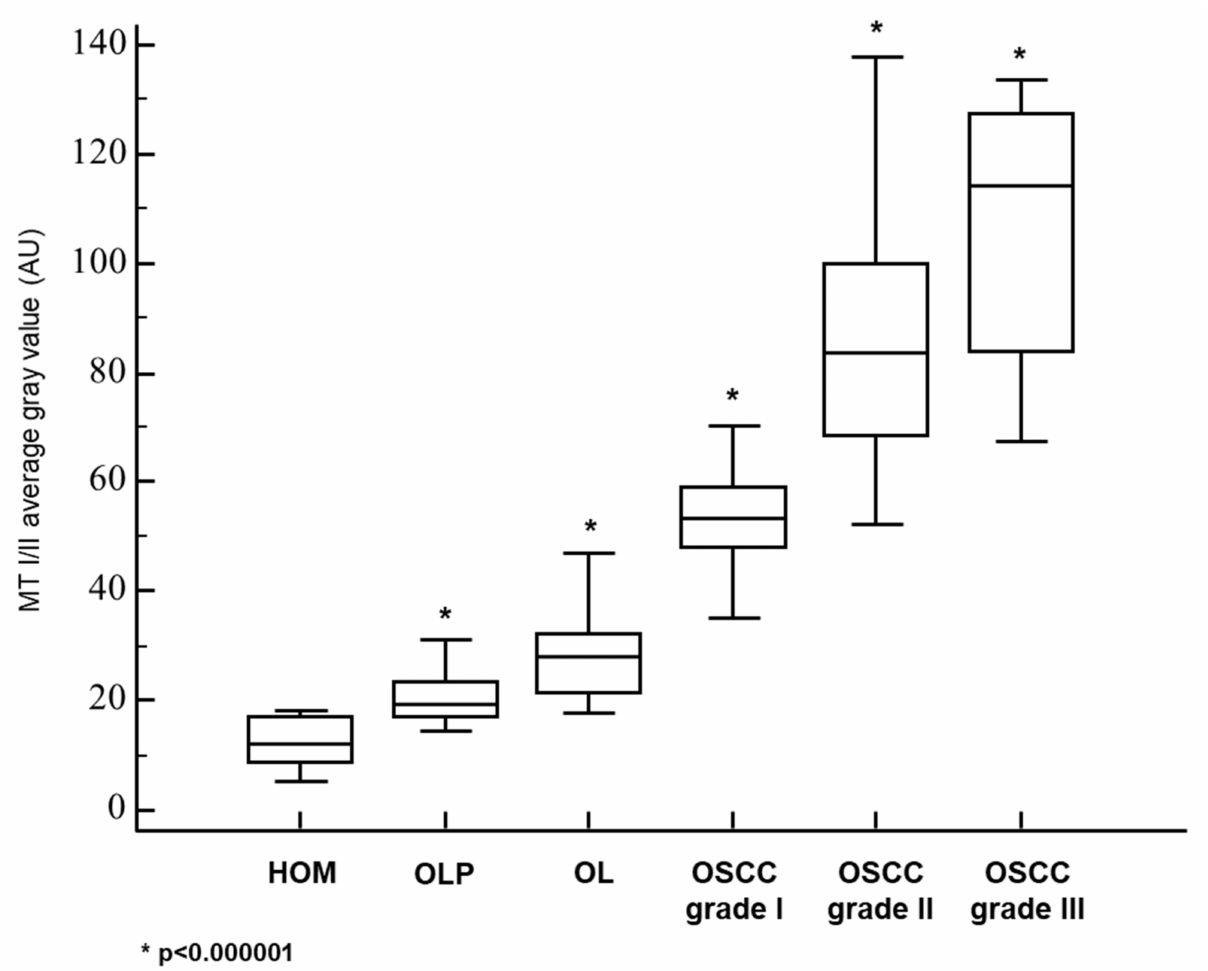
Figure 2. Quantified metallothionein I/II staining intensities in premalignant and malignant oral squamous epithelial lesions. The measurements were made by ImageJ software and data are expressed in arbitrary units (AU) as the median of average gray values with range. HOM, healthy oral mucosa; OLP, oral lichen planus; OSCC, oral squamous cell carcinoma. * p < 0.000001 when each group is compared to the